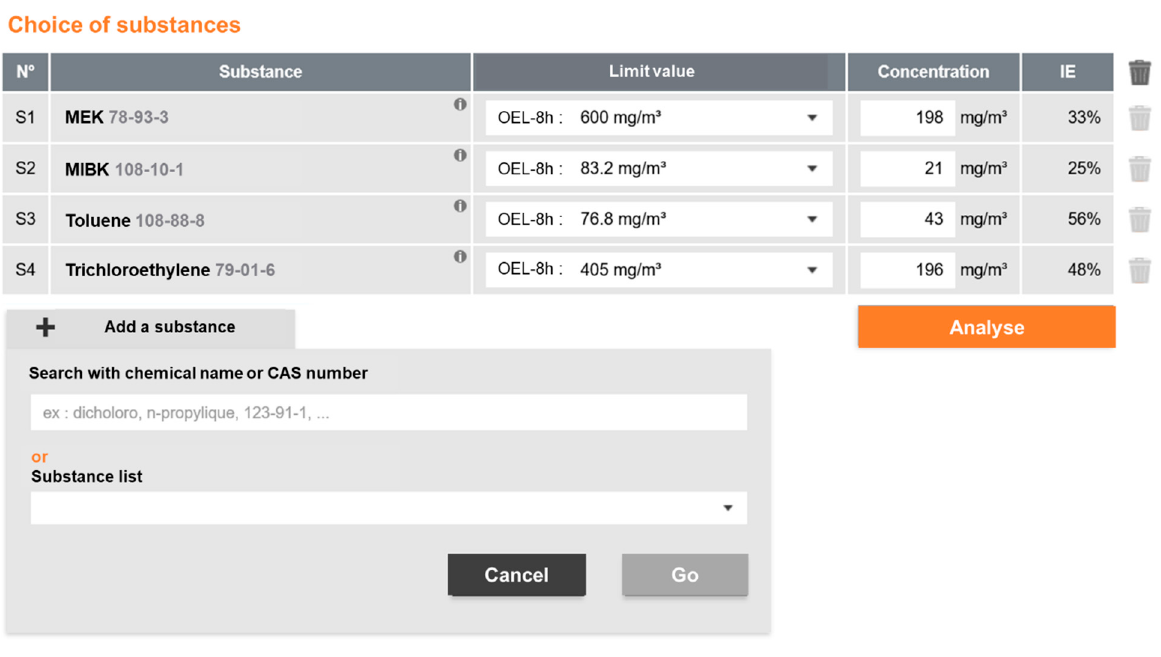
Figure 1. MiXie dashboard.